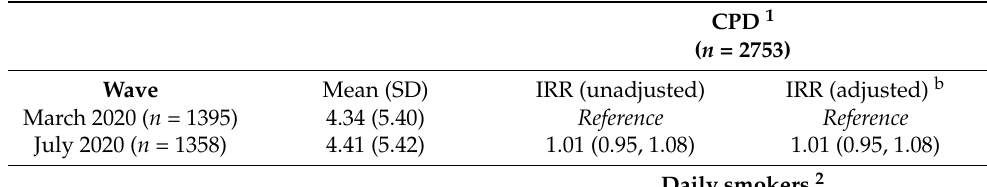
Table 4. Differences in daily smoking, recent quit attempts, and cigarettes per day (CPD) during